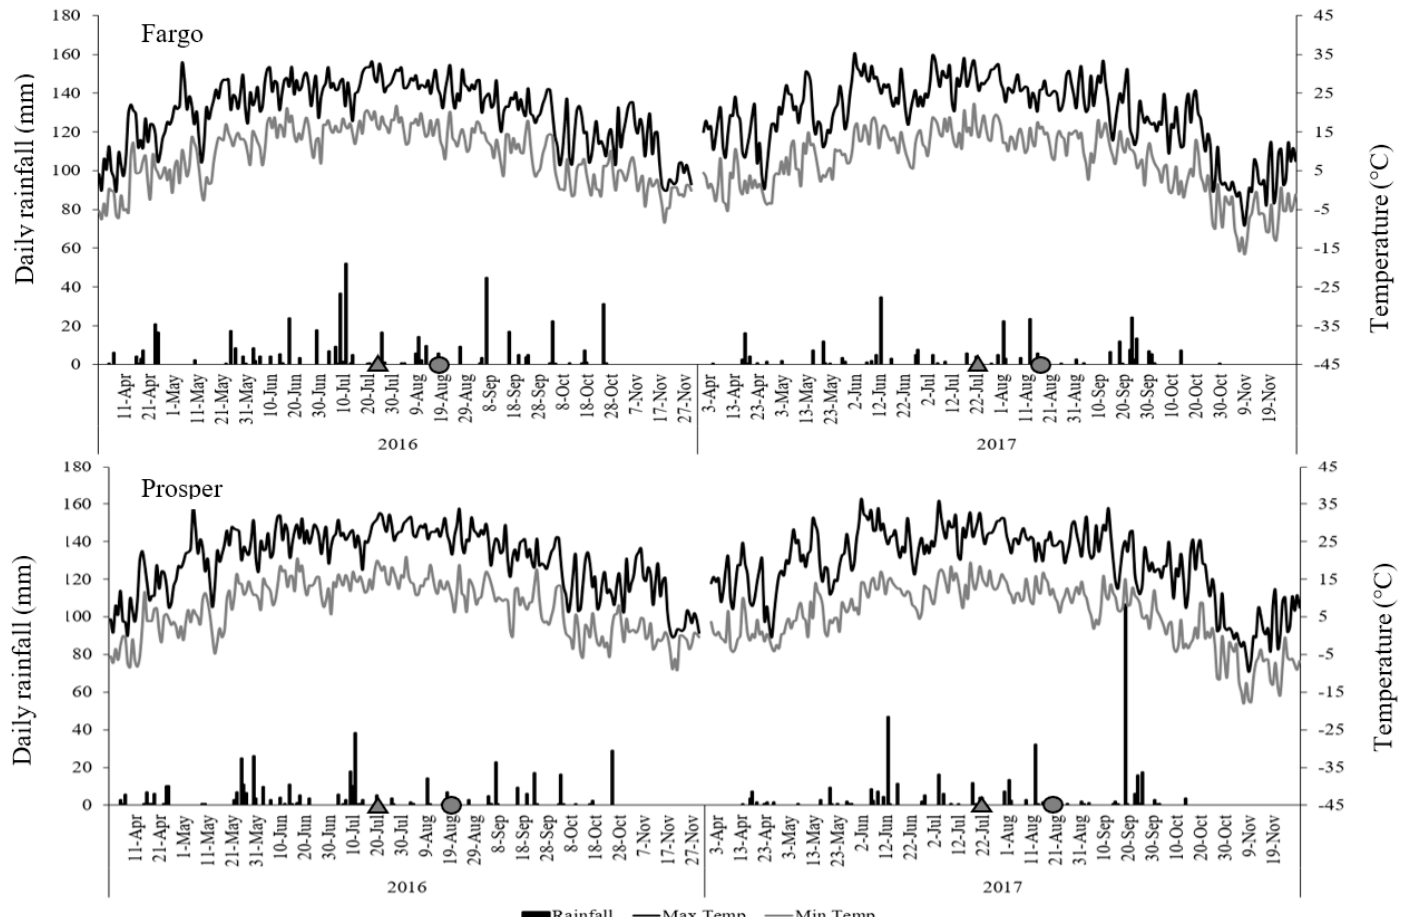
Figure 1. Daily rainfall, maximum temperature, and minimum temperature at Fargo and Prosper, ND, from April 2016 to November 2017. The R4 cover crop sowing dates are represented with an , and the R6 cover crop sowing dates are represented with an .